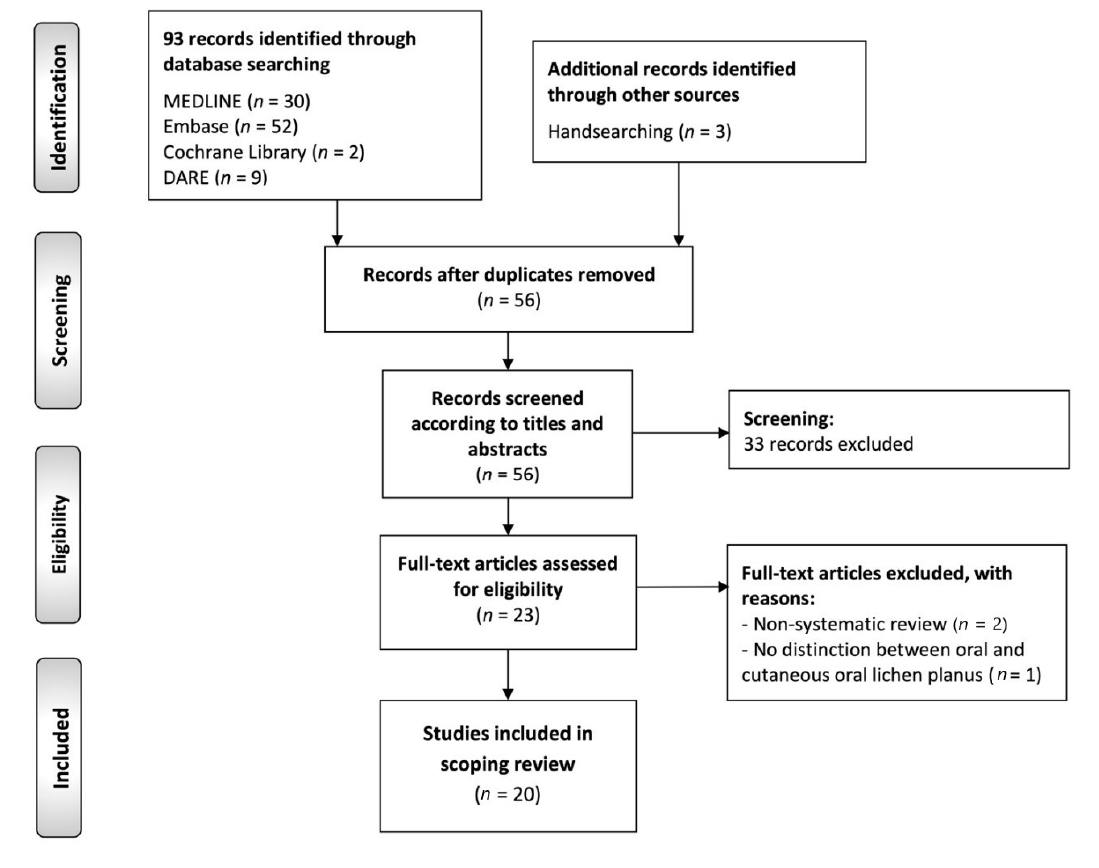
Figure 3. Flow diagram of the identification and selection process of the studies included in this scoping review of systematic